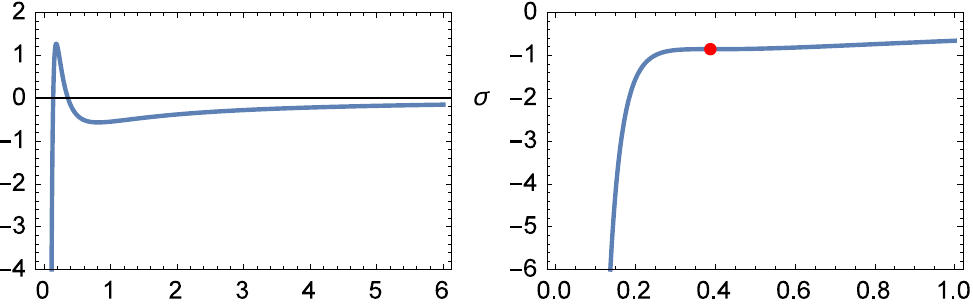
Figure 3. The effective potentials for the Axion DM. ( Left ) There is a barrier formed by the angular momentum and a bottom formed by the gravity on its right. ( Right ) The barrier top and the bottom merge at a special scale (marked by a red point) and the BEC portion inside this scale generates